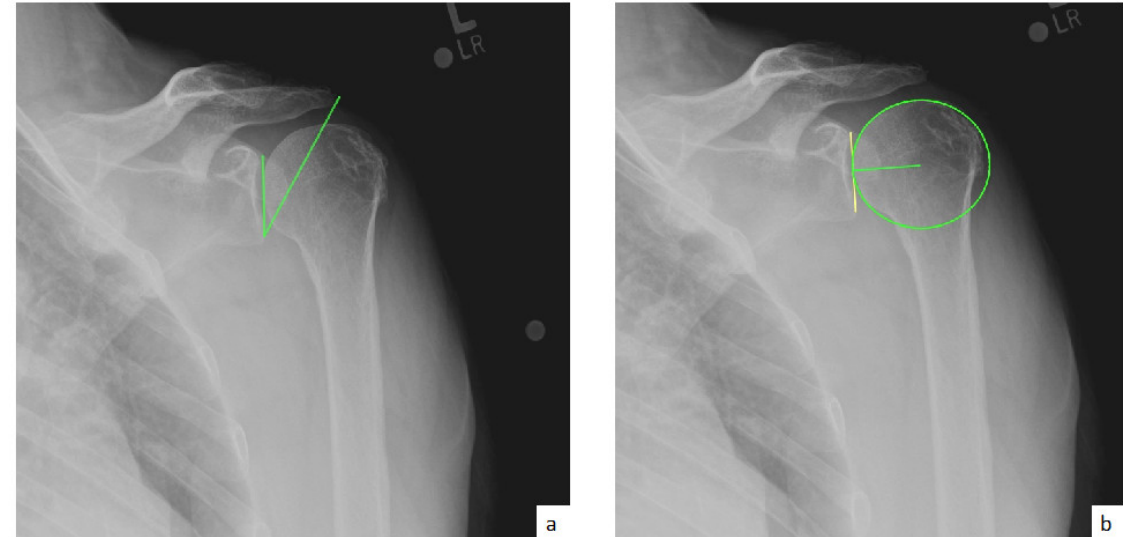
Figure 5. ( a ) Critical shoulder angle (CSA; green angle); ( b ) center of rotation (COI; green line).